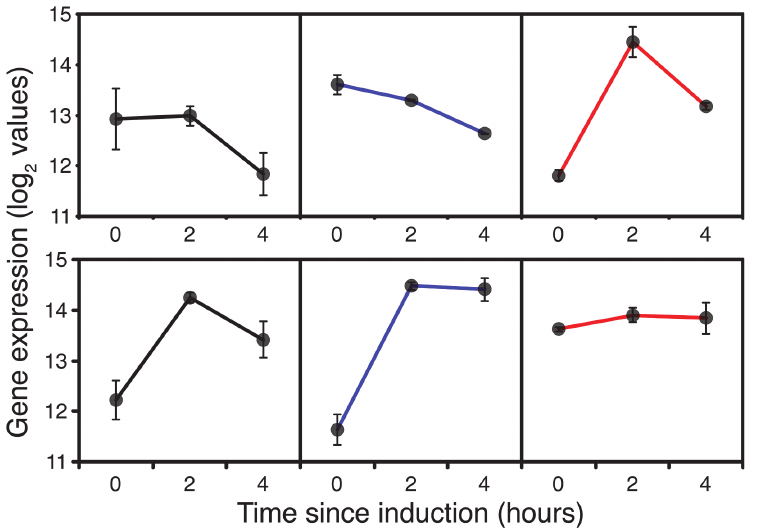
Fig 6. Expression of the gene encoding D-arabitol-2-dehydrogenase (top) and “ YDL124W ” (bottom), 0 (before), 2 and 4 hours after the start of methanol addition to wild-type GS115 (black), TRY1-1 (blue) and TRY1-3 (red), strains containing 1 and 3 gene copies of the human typsinogen gene, respectively, under the control of the AOX1 promoter. Error bars show SEM.